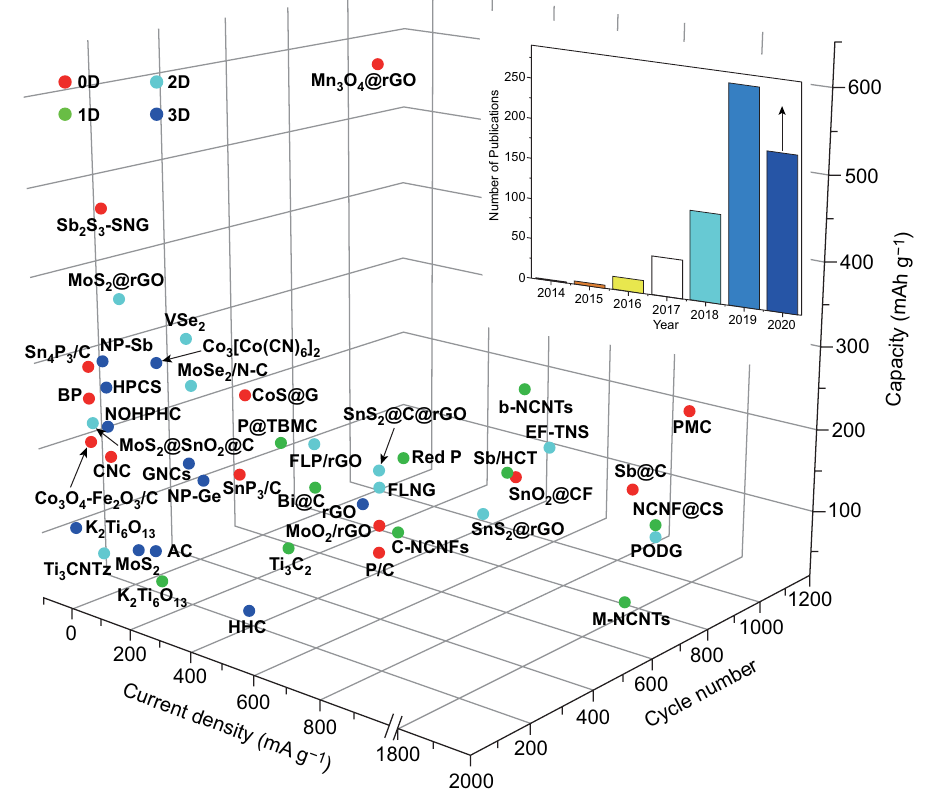
Fig. 1 Cycle capacity of various PIBs anode materials reported recently. Sb 2 S 3 -SNG [38]; Co 3 O 4 -Fe 2 O 3 /C [39]; black phosphorus = BP [33];